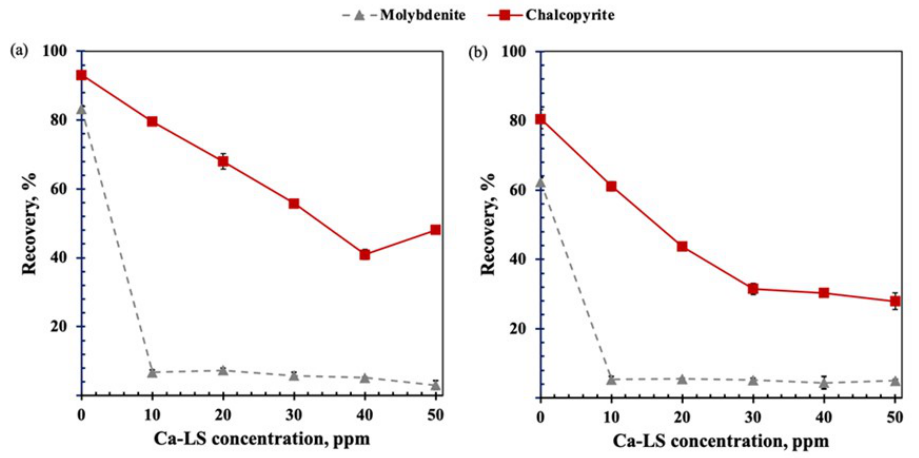
Figure 2. Depressant effect of Ca-LS on molybdenite and chalcopyrite in ( a ) 0.01M NaCl and ( b ) seawater, using 15 ppm MIBC and 25 ppm PAX as chalcopyrite collector at pH